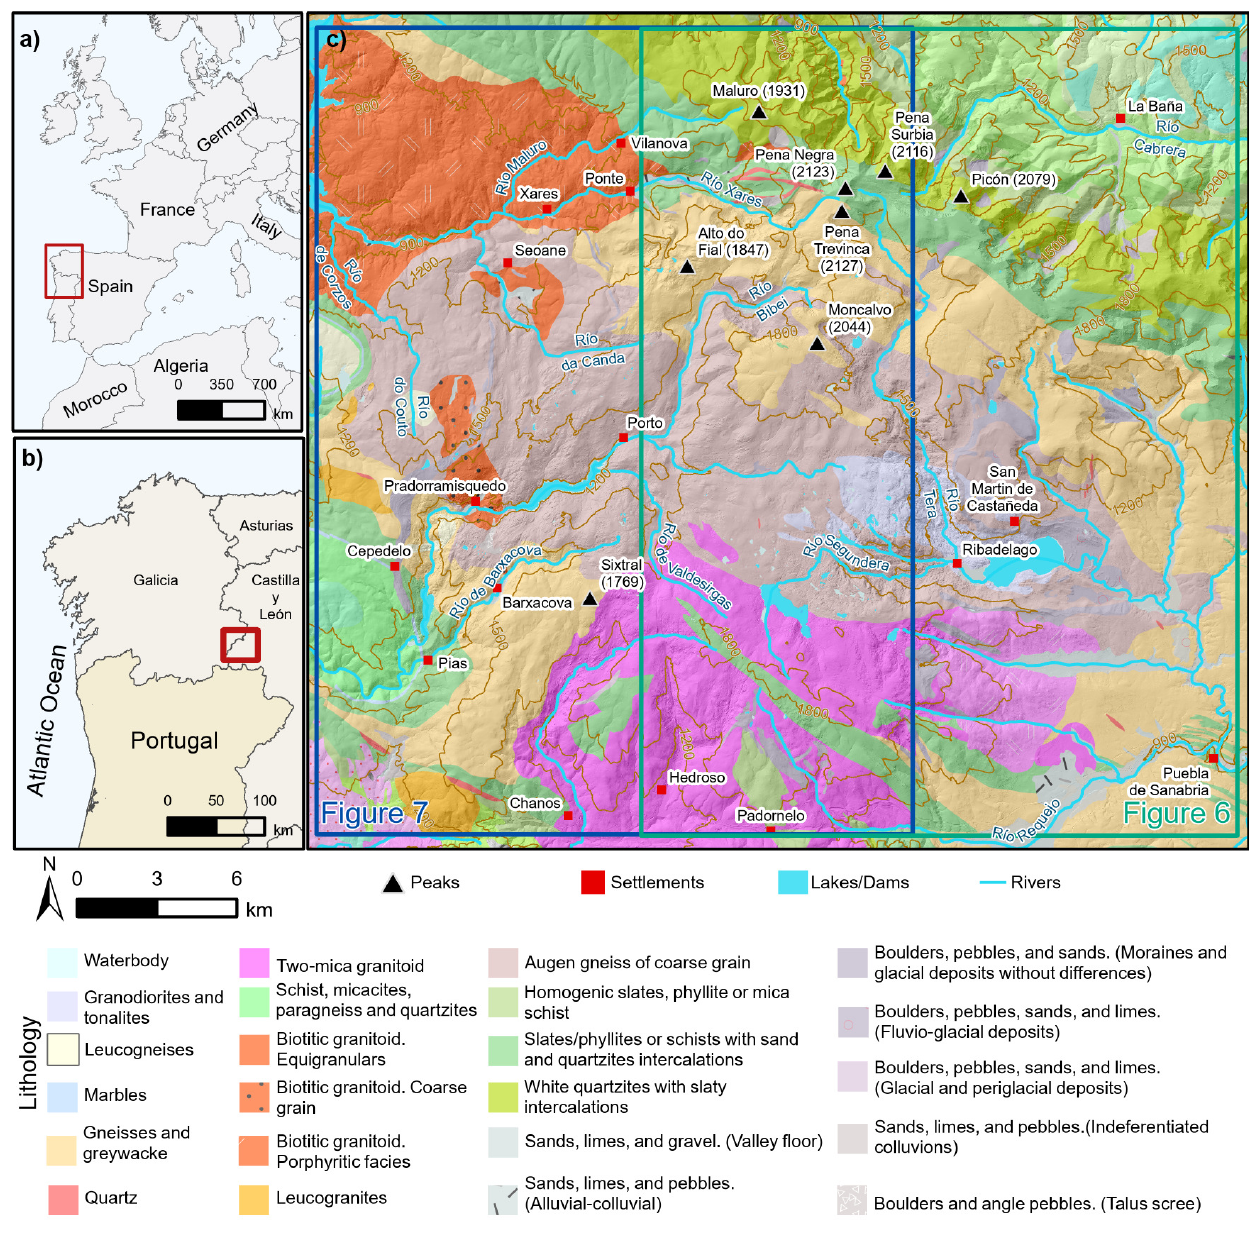
Figure 1. Geological map of the Trevinca Massif. ( a , b ) represent the study sector location in the European and peninsular context; the red polygons in ( a , b ) indicate the frame extension in ( b , c ), respectively. Source of geological information: IGME (Instituto Geológico y Minero de